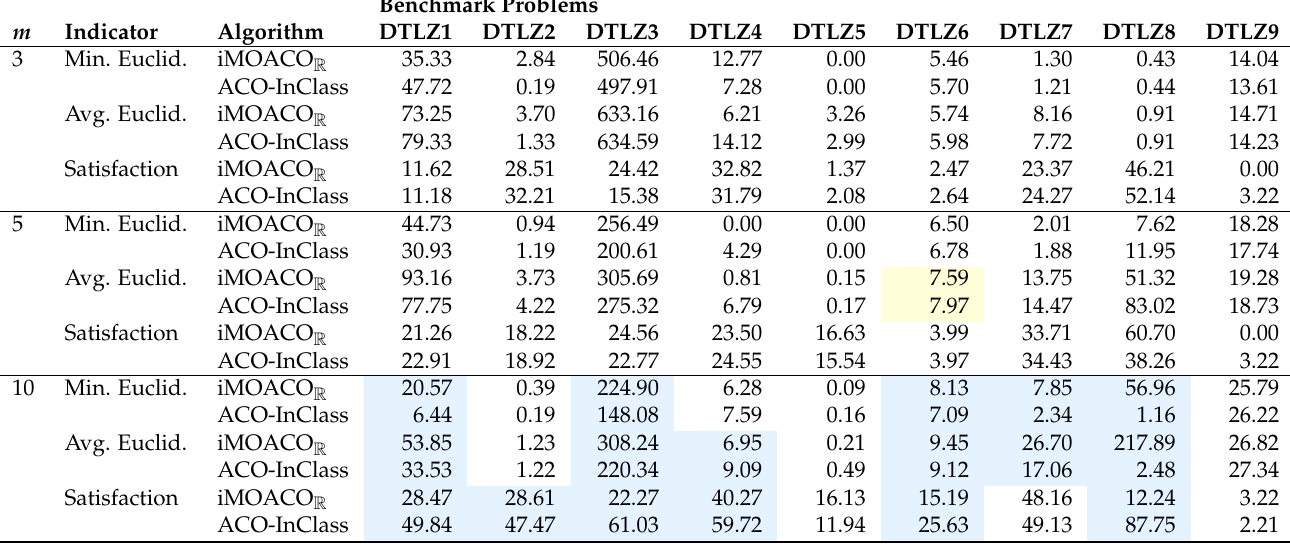
Table 3. Average results obtained by ACO-InClass and iMOACO R